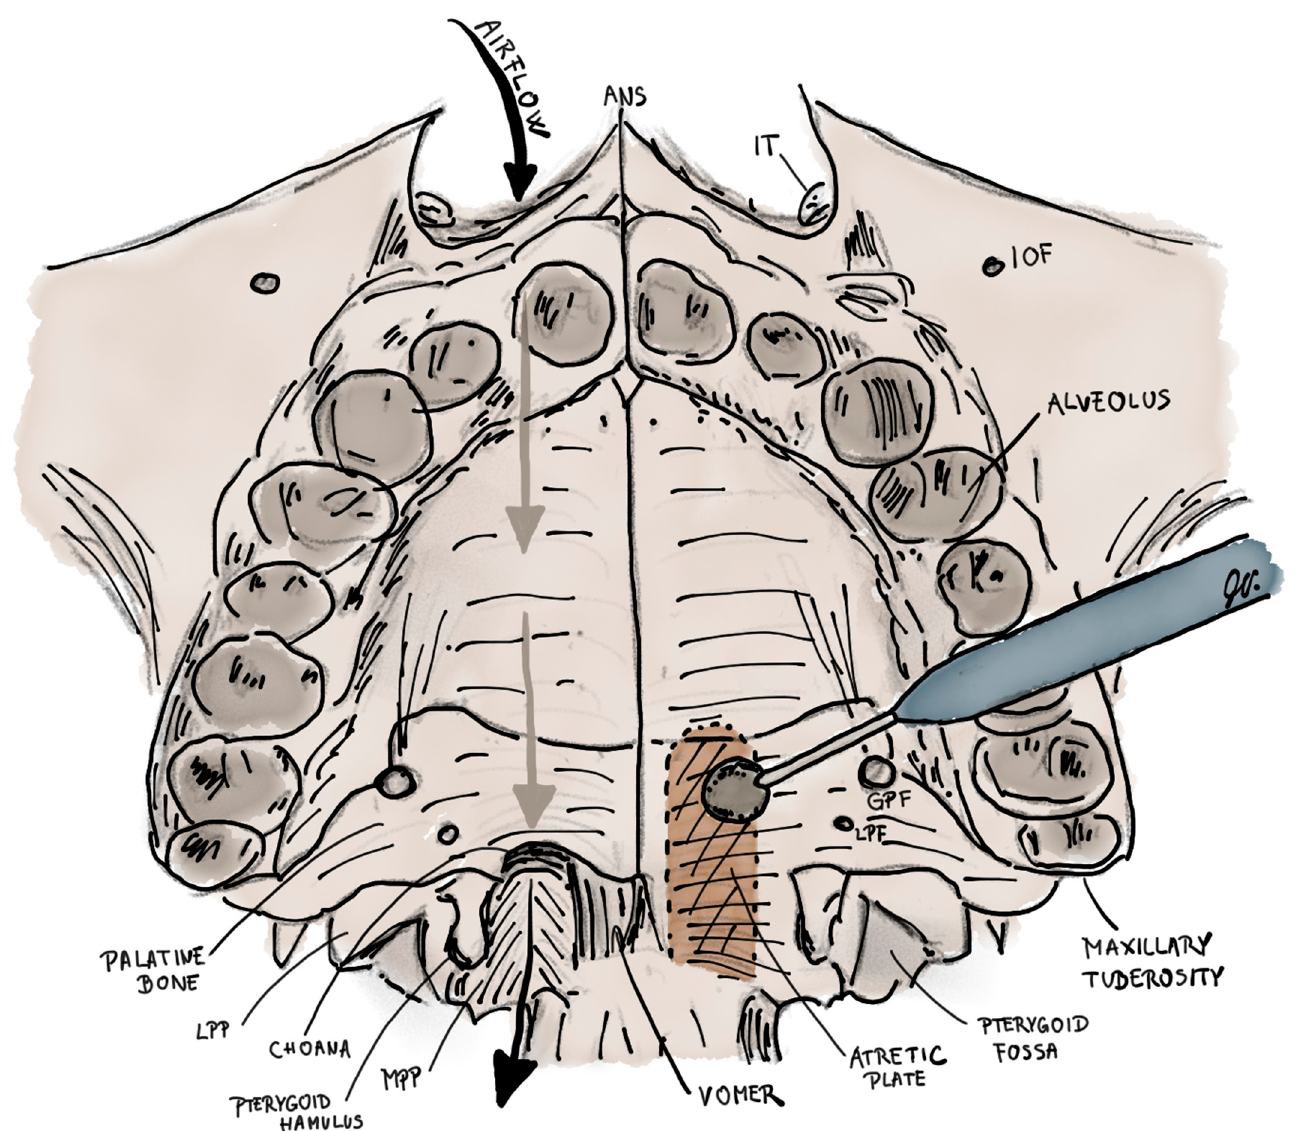
Figure 6. Illustration of transpalatal resection for the treatment of left-sided choanal atresia. Right nasal cavity has a normal patency. First the palatal flap pedicled posteriorly on both greater palatine arteries is elevated to expose the bone of hard palate. Then, the atretic plate, which is located between vomer and medial pterygoid plate, is burred (coloured brown) up to the height to the base of sphenoid sinus, medially to the vomer and laterally to the level of medial pterygoid plate. ANS–anterior nasal spine; IT–inferior turbinate; IOF–infraorbital foramen; LPP–lateral pterygoid plate; MPP–medial pterygoid plate; GPF–greater palatine foramen; LPF–lesser palatine foramen.